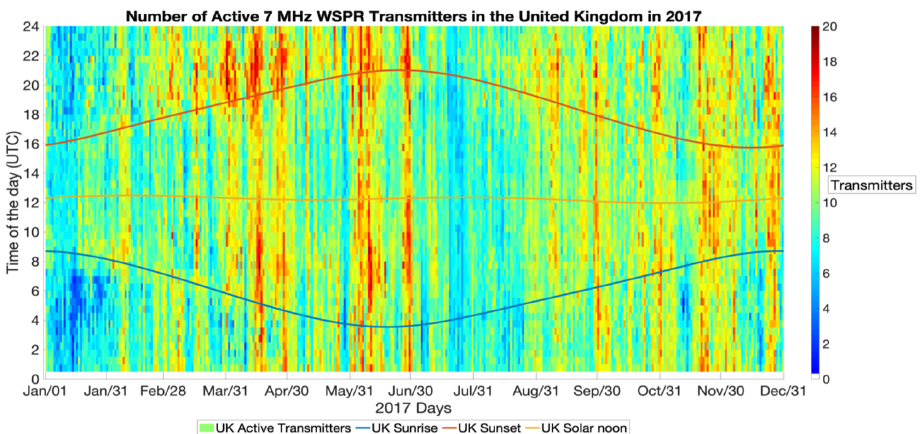
Figure 6. Number of active UK WSPR transmitters in 2017. Only transmitters with a proven capability to cover the distance from the UK to New Zealand and from the UK to Eastern Australia are shown. The colours indicate the number of transmitters available in each half-hour interval.